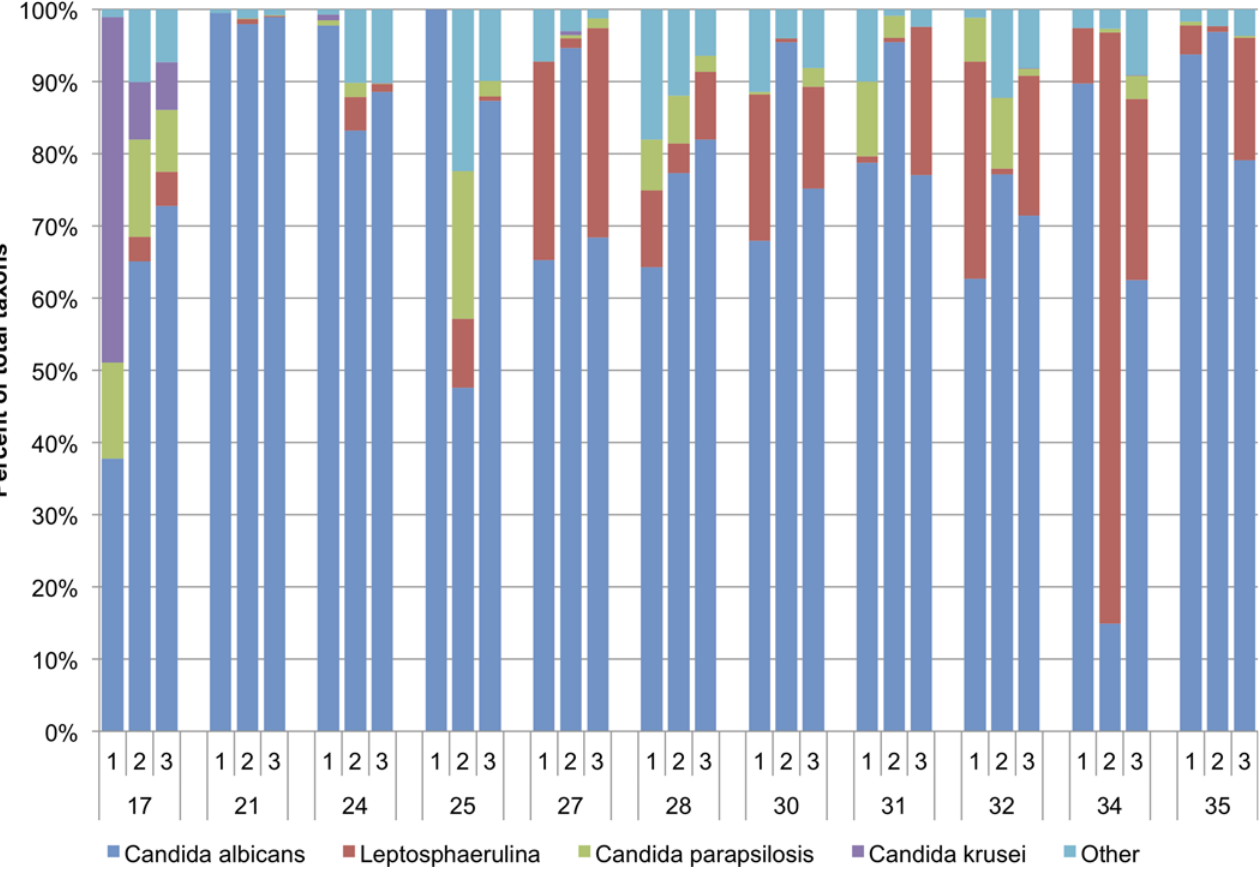
Fig 3. Relative abundances of fungal taxa in infant fecal samples. Sample numbers (each from different infants) are noted on the lower line of the x-axis and the results of triplicate determinations are shown above the sample number for each. The most abundant taxa are indicated on the right-hand side of the graph, with low-abundance taxa (present at < 1.5% mean abundance across all samples) being grouped into the “ Other ” category. Sequencing reads are displayed as percentages of the total number of reads for each individual sequencing replicate. Full dataset results for all taxa as well as raw percentage values are presented in S2